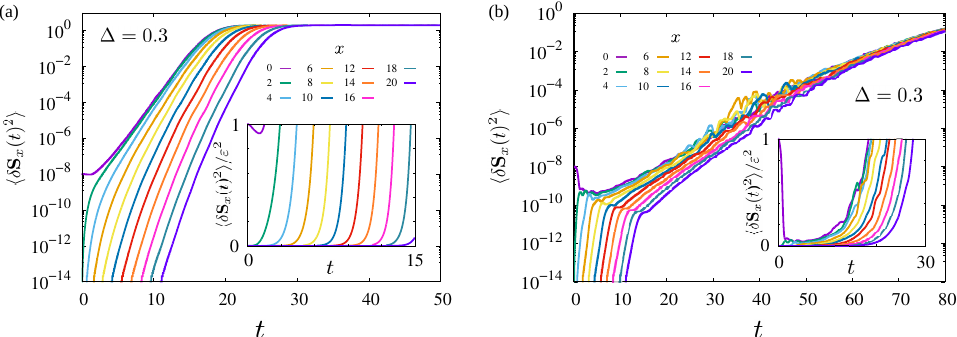
Figure 12: Trajectory divergence: We plot the time evolution of conventional trajec- ( t )) 2 〉 at different sites x = 0,2,4,...,20 for (a) T = 2.00 and tory divergence, 〈 ( δ S x (b) T = 0.50 for easy-plane anisotropy ∆ = 0.3. In the insets, we show zoomed-in view of the early time evolution of the same